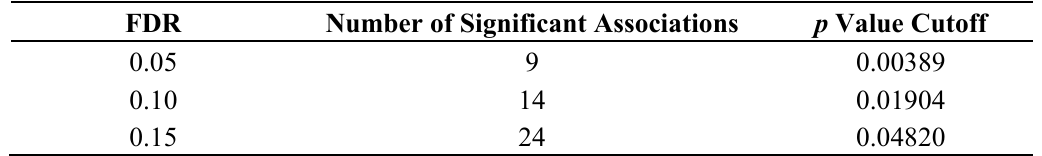
Table 3. False discovery rate (FDR) table for association between REST score and IC cell line